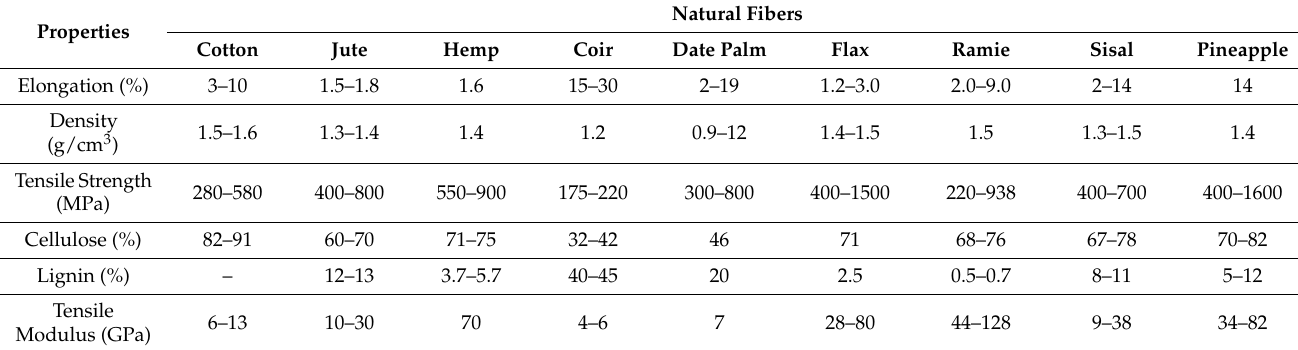
Table 1. Mechanical properties and composition of the most common natural fibers